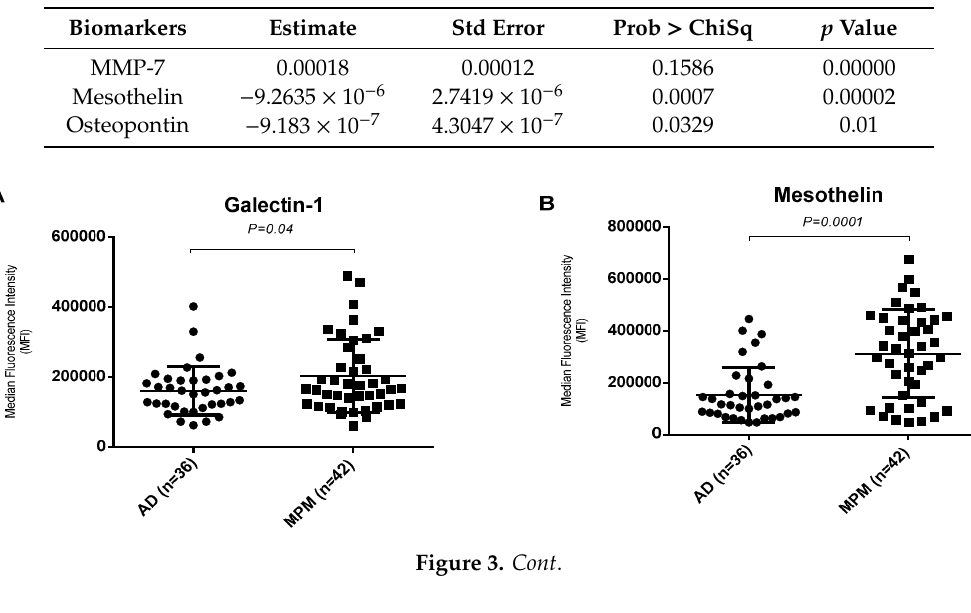
Table 1. Parameter estimates of logistic regression model. MMP-7 has higher predictive value for distinguishing malignant pleural mesothelioma from adenocarcinoma, based on estimate and p -value. Biomarkers